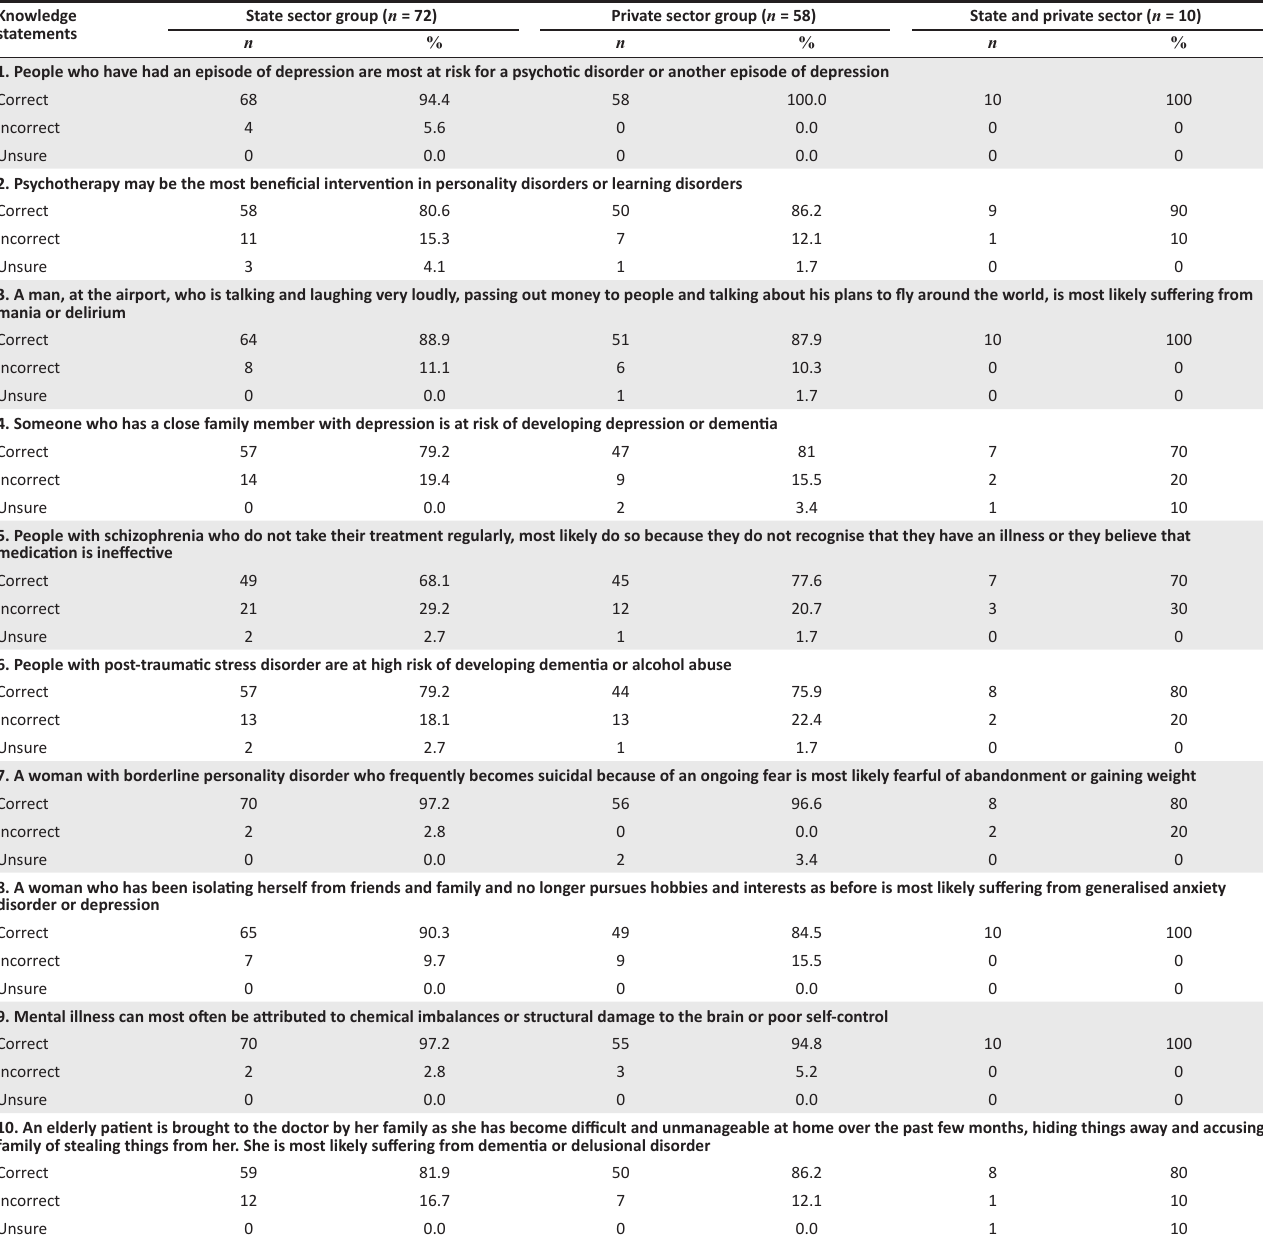
TABLE 3: The frequency distribution of responses for each of the questions in the study population. Knowledge